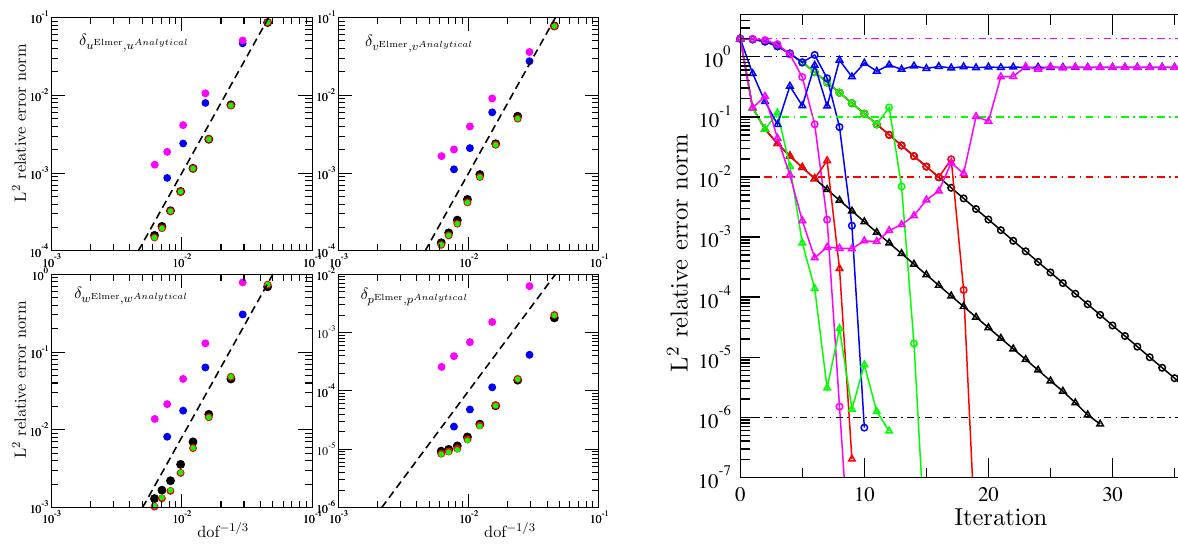
Fig. 1. Results of the convergence tests: L 2 relative error norm be- tween Elmer/Ice and analytical solutions for the 3 components of the velocity (u,v,w) and the pressure, p , as a function of the grid size (which is proportional to the inverse of the cubic root of the degrees of freedom) for Franca and Frey (1992) stabilisation with (black) 6-node wedge element, (red) 8-node hexahedron element and with (blue) 20-node hexahedron element; and for the residual free bubbles stabilisation (Baiocchi et al., 1993) with (green) 8-node hexahedron element and with (magenta) 20-node hexahedron ele- ment. The black dashed line indicates a rate of convergence of 3.